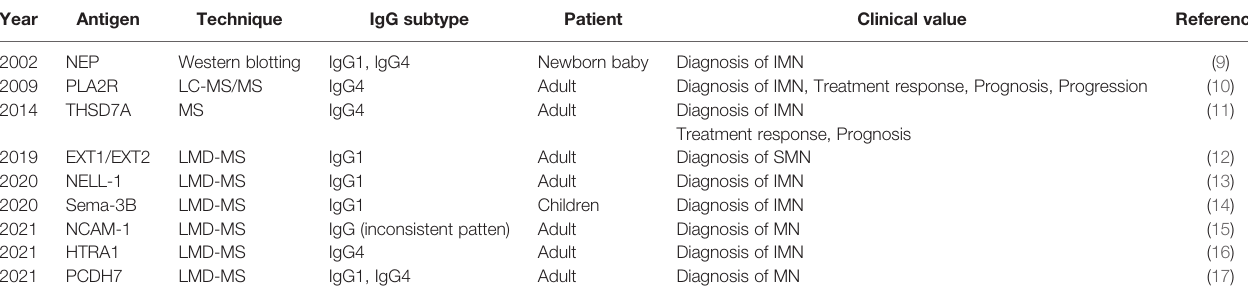
TABLE 1 | Summary of research progress on MN-related human podocyte target antigens.